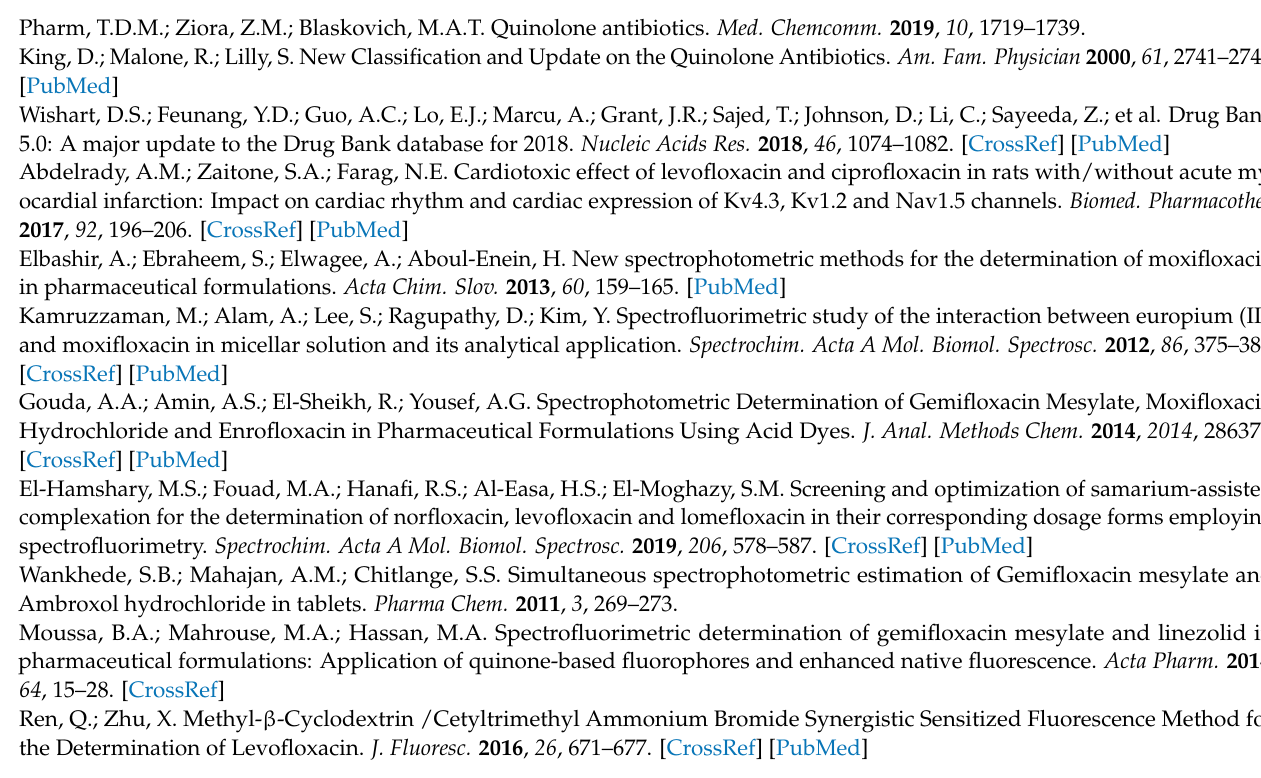
Figure S2: HPTLC densitogram of: (a) Advancrib ® tablets sample containing 0.5 µ g/band of MX, (b) Monosho ® tablets sample containing 0.5 µ g/band of LV, and (c) Quinabiotic ® tablets sample containing 0.6 µ g/band of GM using the proposed HPTLC